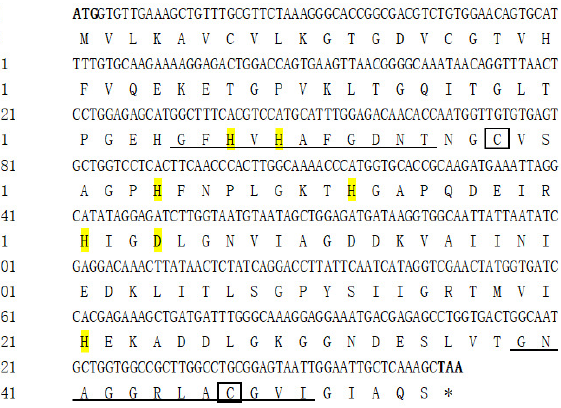
Figure 1. The nucleotide and deduced amino acid sequence of AdCu/Zn-SOD (Cu/Zn superoxide dismutase from Yangtze sturgeon). Two conserved signature sequences are marked by underlining; four Cu 2+ -binding active sites (His 47 , His 49 , His 64 , and His 121 ) and four Zn 2+ -binding active sites (His 64 , His 72 , His 81 and Asp 84 ) are highlighted in yellow; and two cysteine residues (Cys 58 and Cys 147 ) are boxed, * indicates a stop codon.